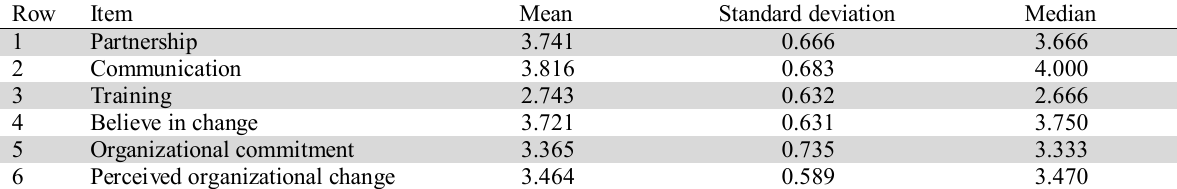
The summary of some basic statistics